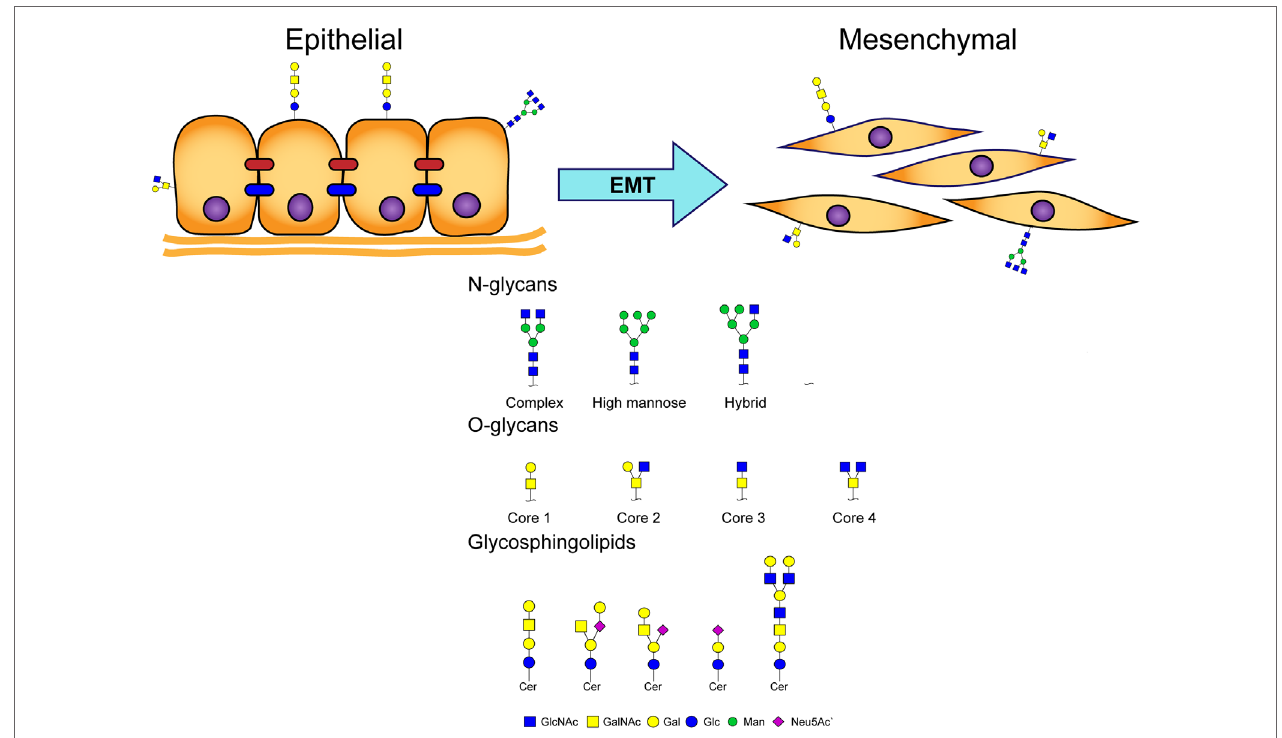
FiGURe 1 | Major classes of glycans involved in eMT process